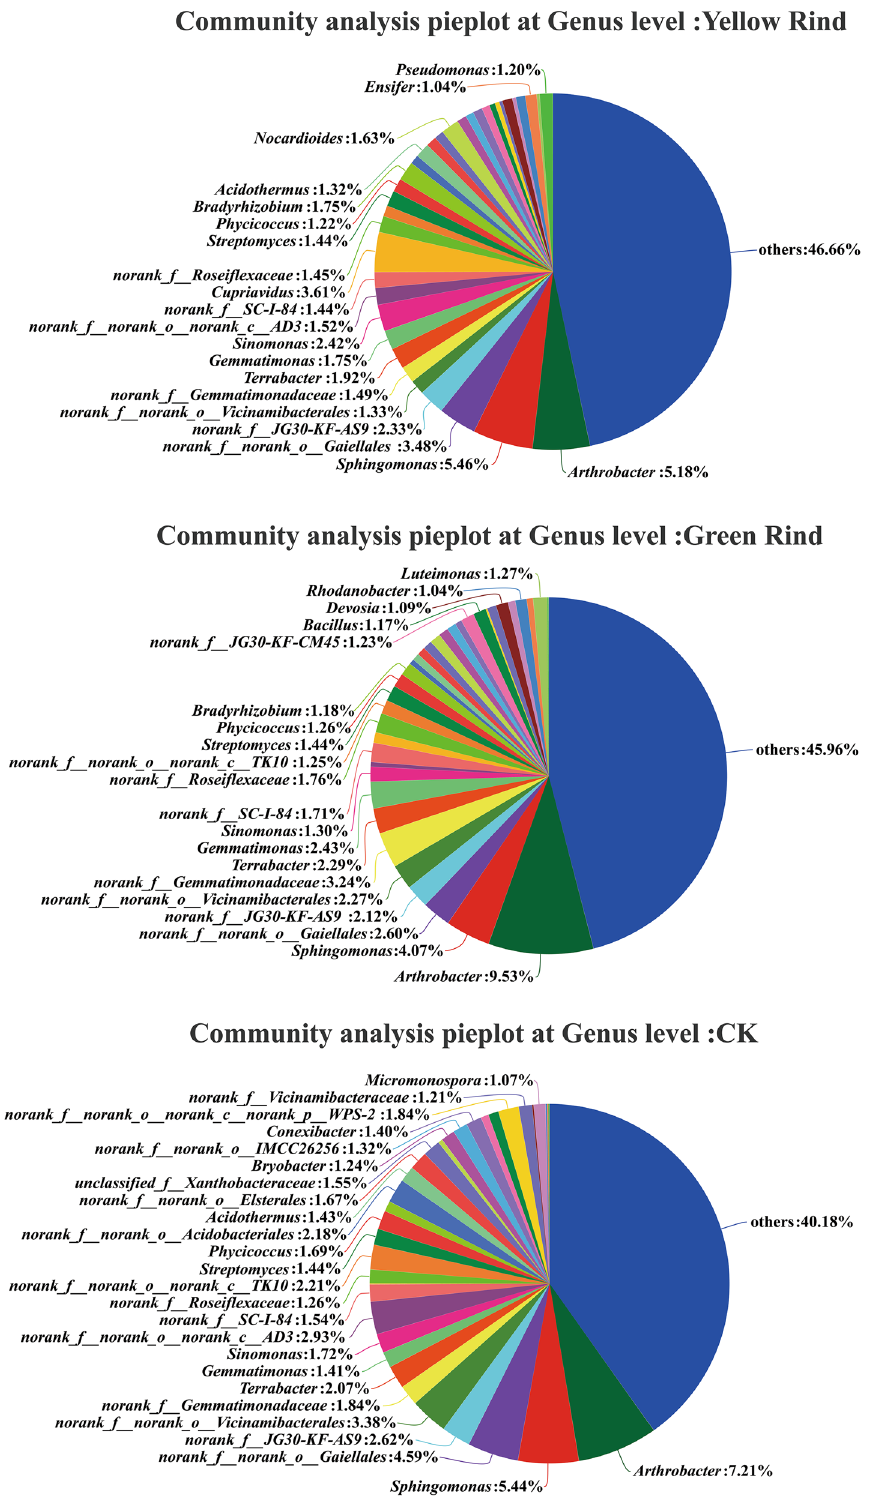
Figure 5. Compositions and proportions of soil dominant bacteria in rhizospheres of yellow, green rind watermelons and CK at genus level. (Sequences that could not be classified into any known group were assigned as “unclassified”. Genera making up less than 1% of total composition in each sample were classified as